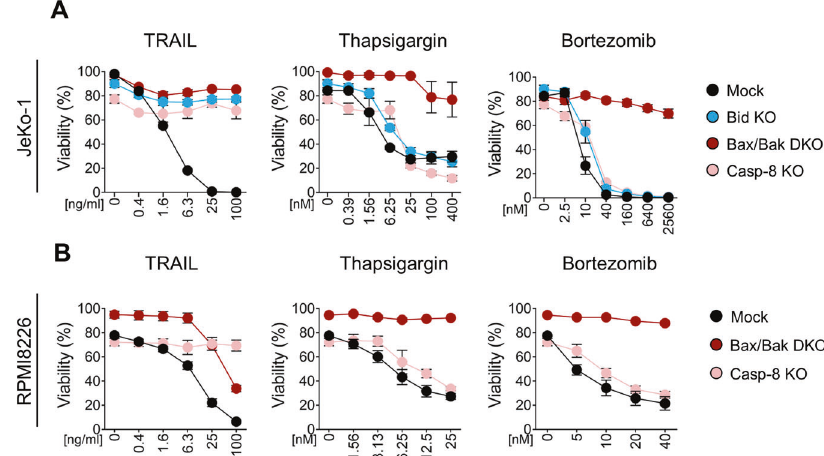
Fig. 4 Consequences of Caspase-8, Bid and Bax/Bak gene ablation for TRAIL and ER-stress cell death responses. A JeKo-1 Mock, Bid KO (clonal population) and Casp-8 KO (clonal population) cells were incubated with TRAIL, Thapsigargin or Bortezomib for 24 hours and Bax/Bak DKO cells for 48 hours. Cells were then collected and viability was measured via FACS. Results are shown as Mean ± SEM ( N = 3). B RPMI8226 Mock, Casp-8 KO (clonal population) and Bax/Bak DKO (clonal population) cells were incubated with TRAIL, Thapsigargin and Bortezomib with the indicated doses. After 24 hours incubation, cells were collected and viability measured via FACS by DiOC6 and ToPro-3 staining. Analyses were performed selecting cells for DiOC6 + and ToPro-3 - . Results are shown as Mean ± SEM ( N =